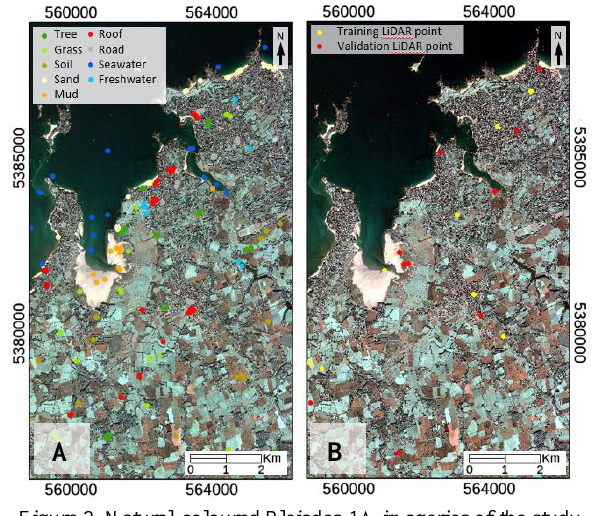
Figure 2. Natural-coloured Pleiades-1A imageries of the study site centered on the bay of Beaussais and Frémur river; (A) Ground-truth LiDAR data; (B) Ground-truth classification data